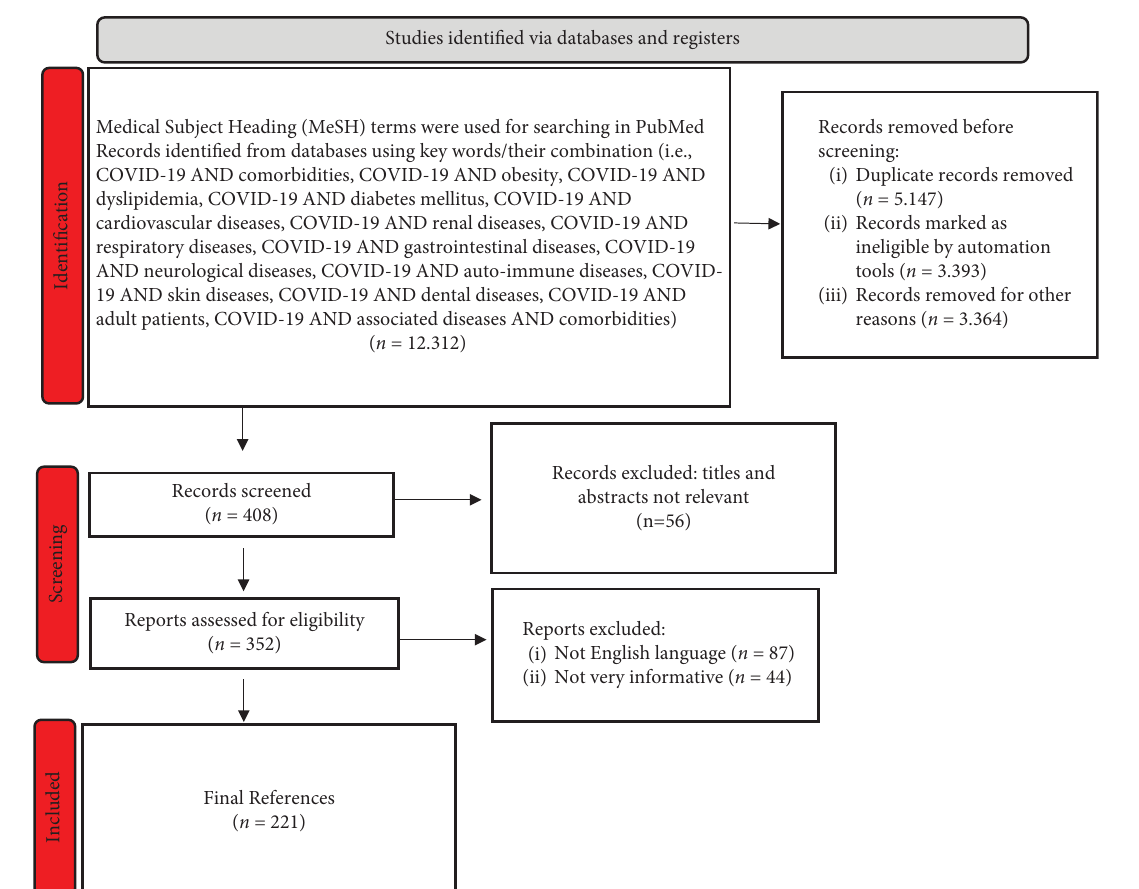
Figure 1: ,e PRISMA flowchart for the selected